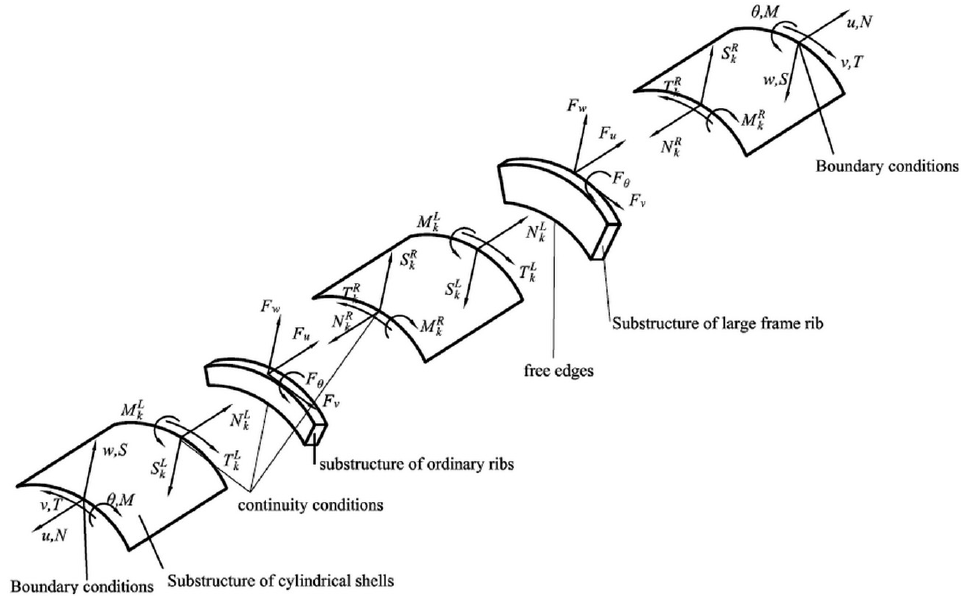
Fig. 1. Substructure divisions of cylindrical shells with intermediate large frame